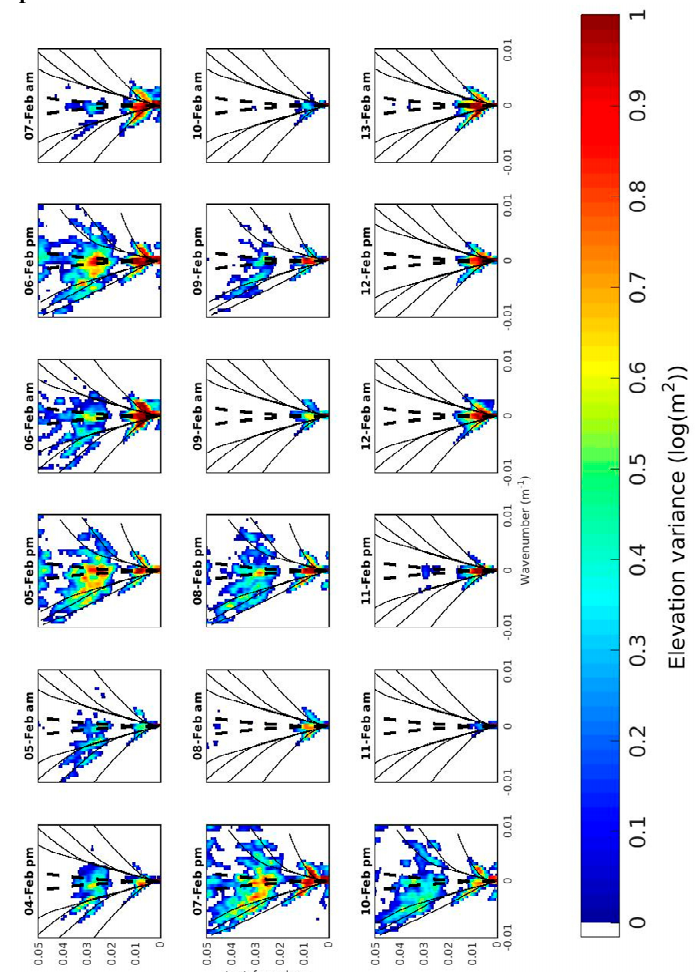
Figure A1. Elevation f - k y spectra, 12-hour averages. The colour bar denotes the elevation variance (m 2 Hz − 1 m − 1 ), plotted on a logarithmic scale with lower values of elevation variance appearing in white. Black solid lines are theoretical dispersion curves (calculated based on the observed alongshore current at the time) and black dashed lines represent the cut-off between edge waves and leaky waves. Positive (negative) wavenumbers represent edge wave progressing southward (northward).